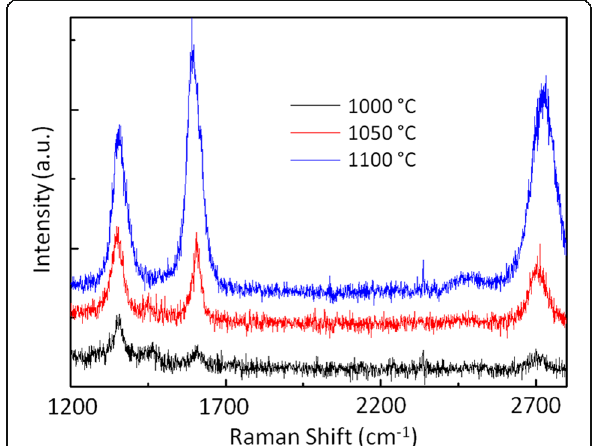
Fig. 6 Micro-Raman characterization of CVD graphene grown directly on